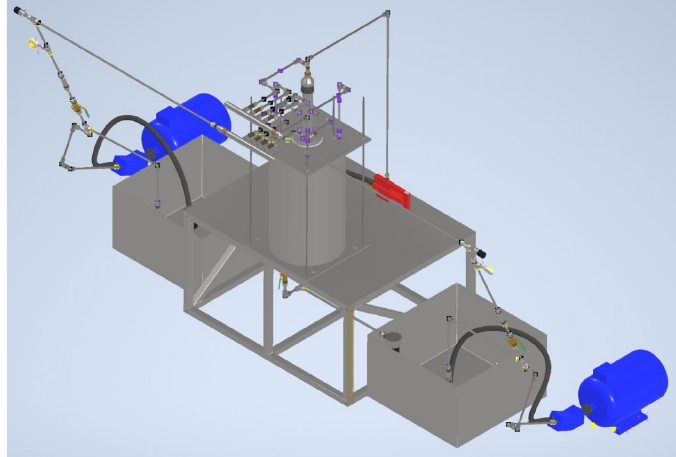
Figure 10. Experimental stand in the assembly.